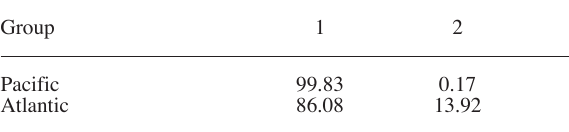
T ABLE 5. – Results of the discriminant analysis classification with normalized data showing the percentage of specimens classified in each ocean using 8 variables (excluding ocular diameter). Wilks’ lambda: 0.6109